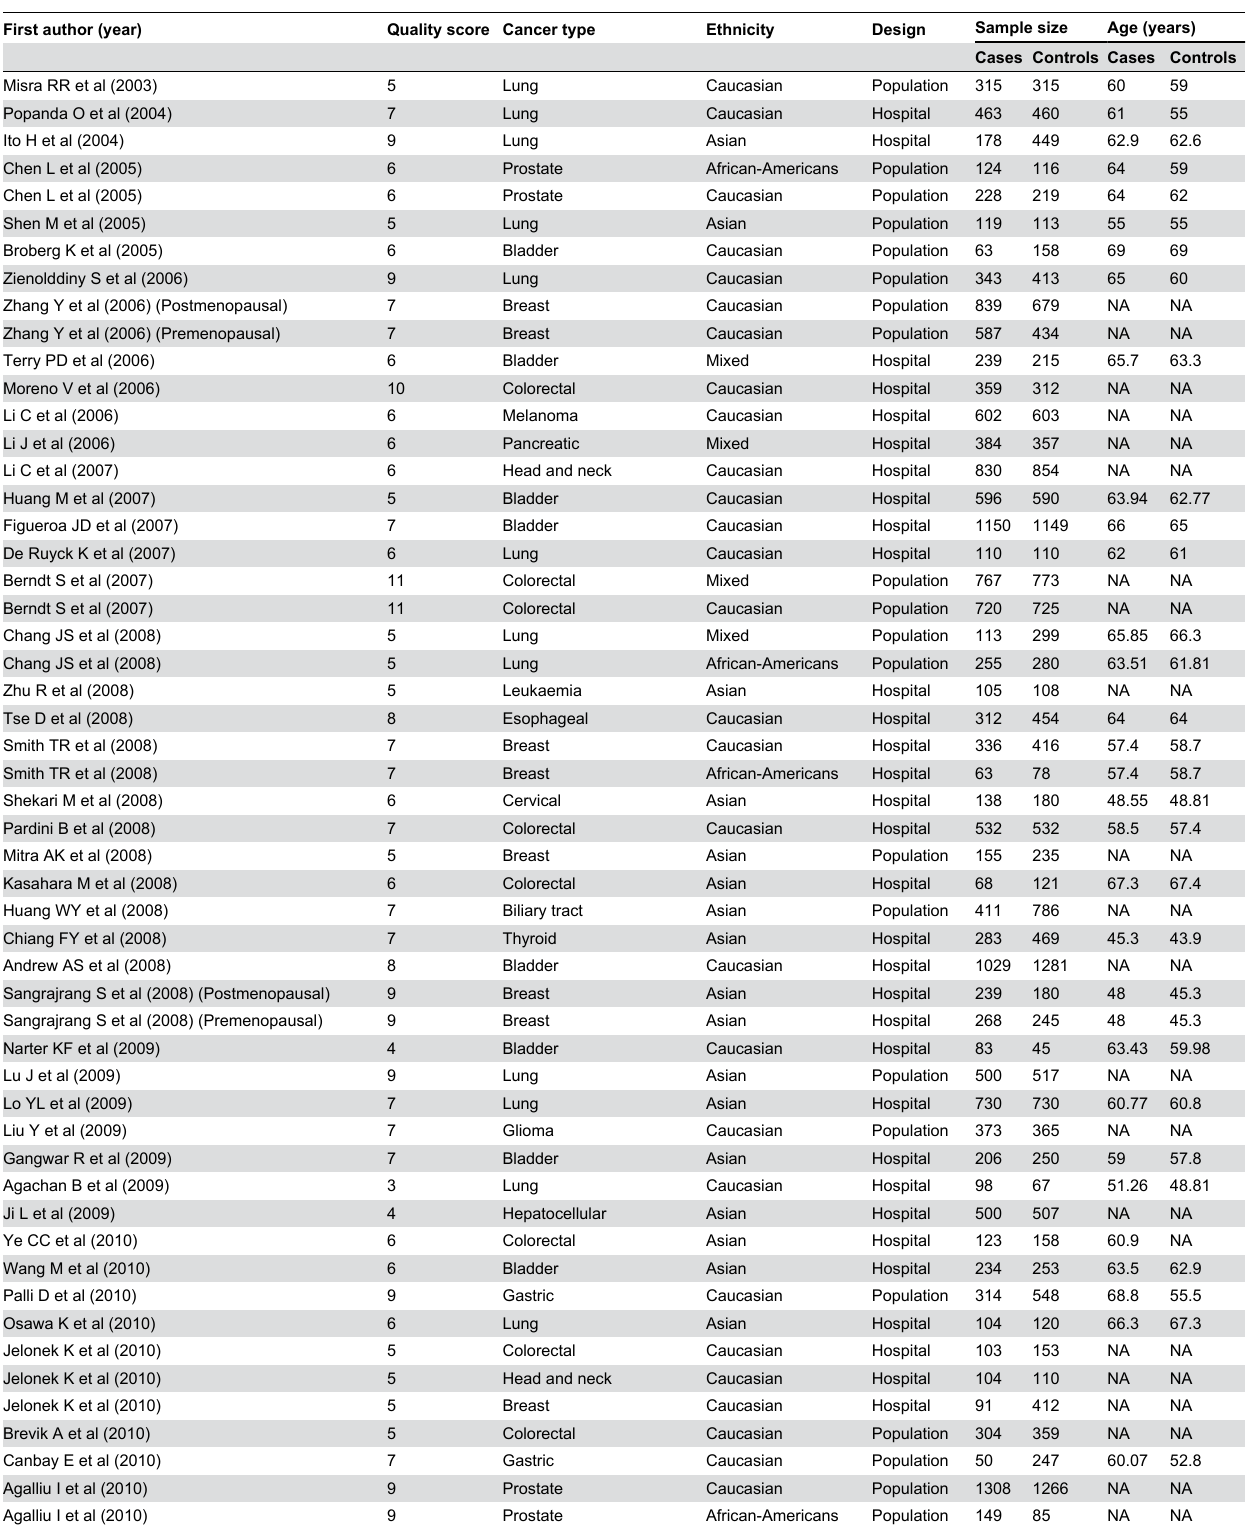
Table 1. The baseline characteristics of the study populations analyzed in this